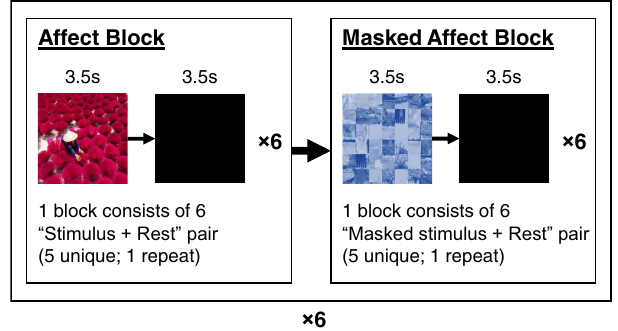
Fig. 6 Schematic illustration of the task-based fMRI paradigm in Study 1. A single run of the task-based fMRI paradigm consisted of 12 blocks (6 pairs of stimulus + masked stimulus blocks). The six pairs of stimulus and masked stimulus blocks corresponded to the three main affect condition (sadness, neutrality, and fear) and the three masked counterparts (sadness-mask, neutrality-mask, and fear-mask) each repeated once (in random, interleaved order). Each block consisted of 6 stimuli and rest pairs ( fi ve of which are unique, while one would be a repeat that immediately follows the original). The participants were required to press on the button box when they viewed a repeated